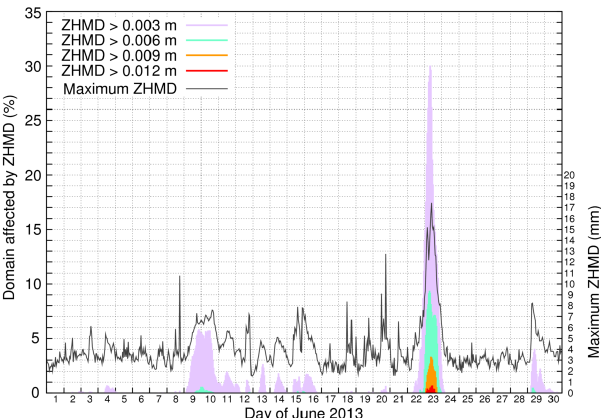
Figure 11. ZHMD contributions to zenith delays simulated with ALADIN-CZ model (June 2013) ranking in four classes (ZHMD>0.003m, ZHMD>0.006m, ZHMD>0.009m, and ZHMD>0.012m) shown respectively in purple, turquoise blue, orange and red. The maximum ZHMD (in mm) is shown with a dark grey line.